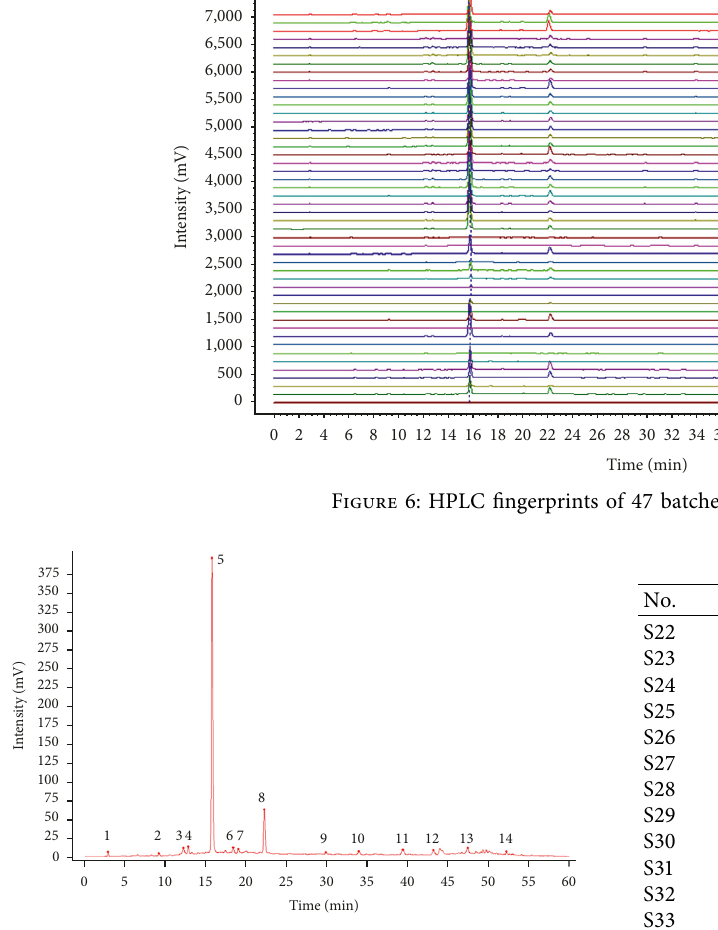
Figure 7: Common peaks of HPLC fingerprints of Acacia catechu .